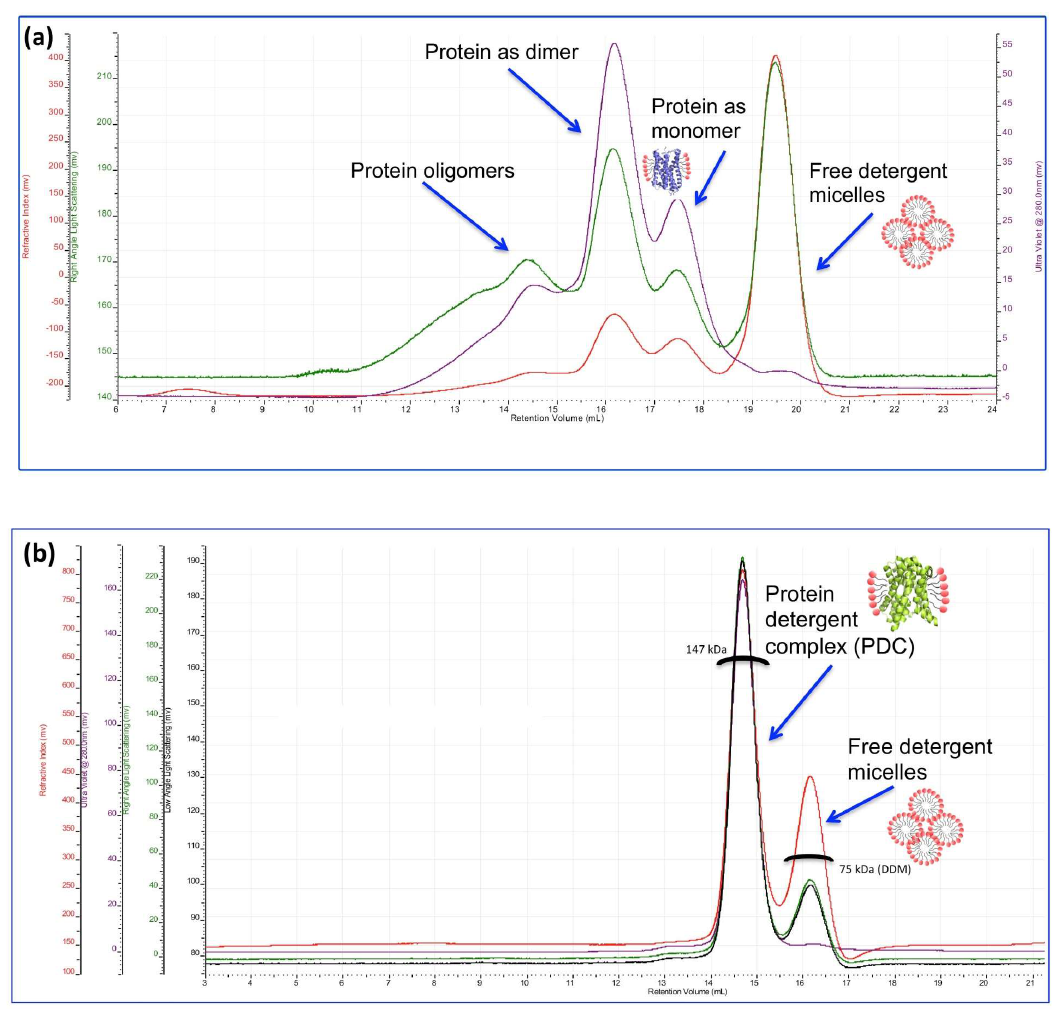
Figure 5. SEC-MALS analysis of two different membrane proteins. The different chromatograms correspond to the different detector signals. The trace in purple corresponds to the ultraviolet (UV) signal, green and black to the light scattering (LS) signal, and red to the refracting index (RI) signal. Panel ( a ) shows a SEC-MALS analysis of a membrane protein purified in 6-Cyclohexyl-1-Hexyl-β- D